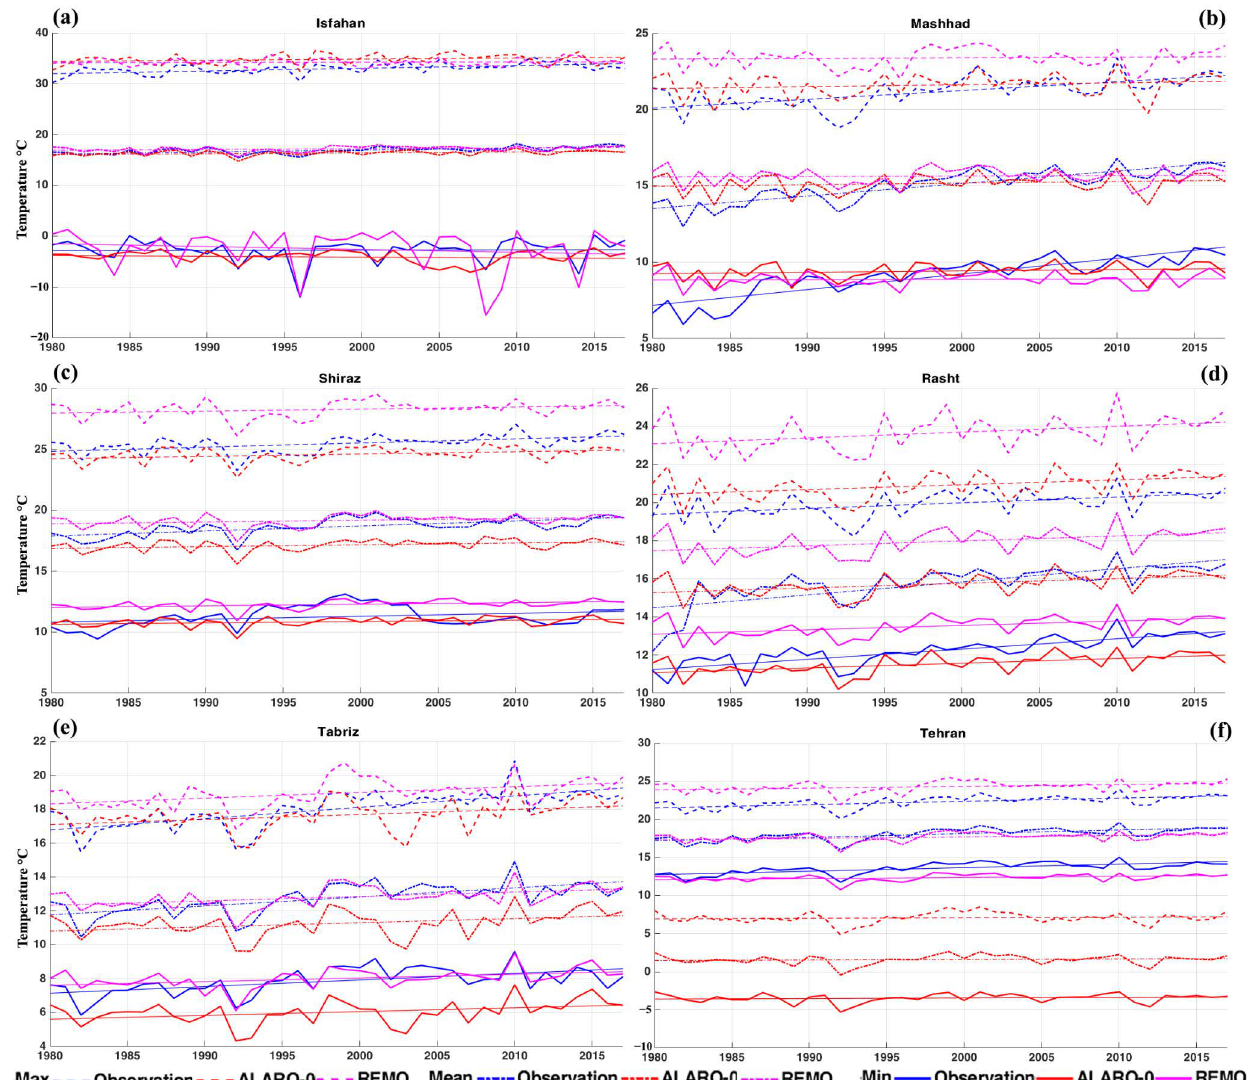
Figure 2. Maximum, mean and minimum temperature comparing models with observations for Isfahan ( a ), Mashhad ( b ), Shiraz ( c ), Rasht ( d ), Tabriz ( e ) and Tehran ( f ) during